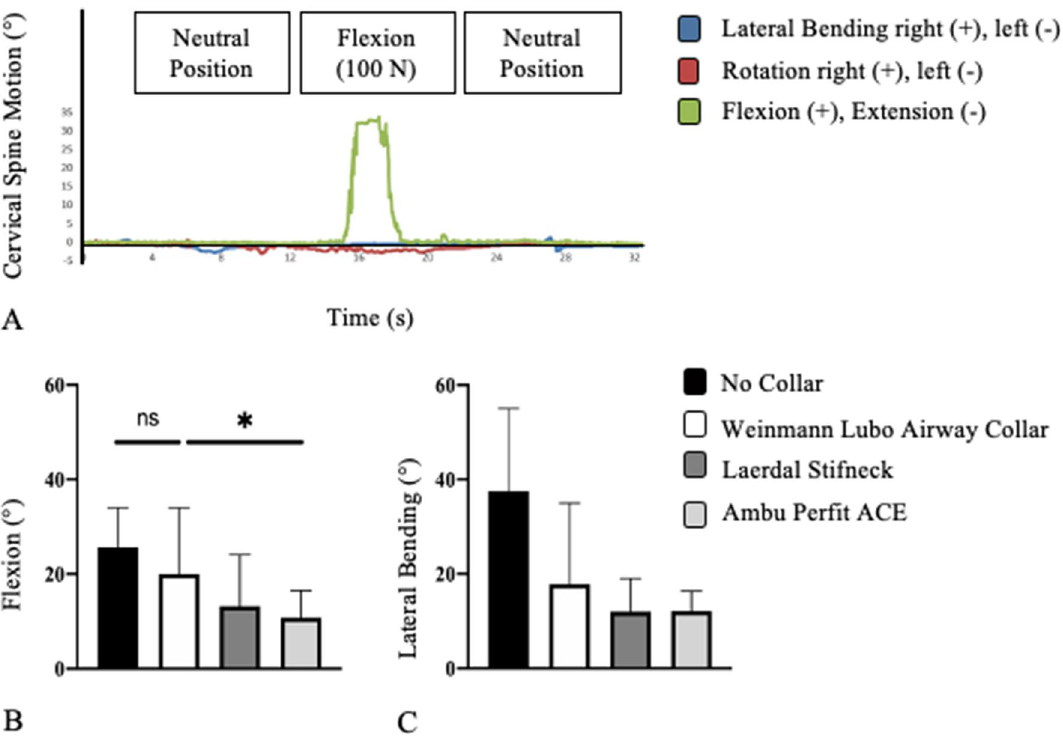
Figure 3. Remaining flexion of the cervical spine if an innovative cervical collar is applied ( A ). Range of remaining flexion of the cervical spine ( B ) and range of remaining lateral bending ( C ) of the three tested cervical collars ( B , C : Only significant differences are